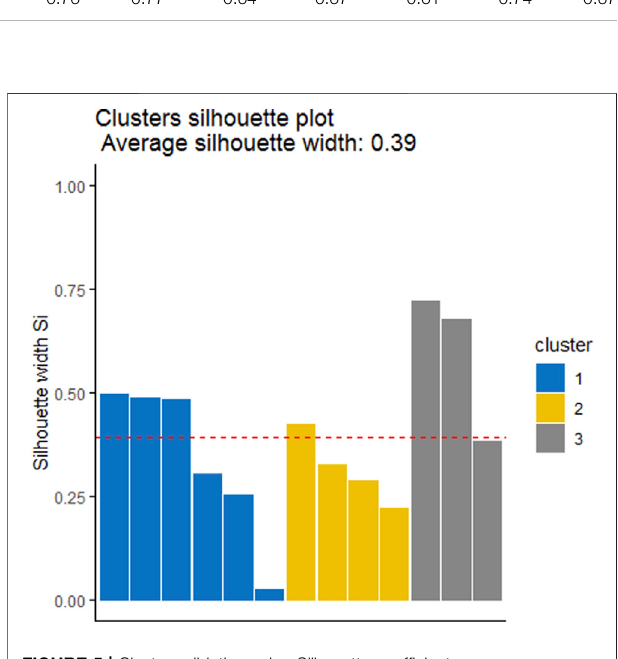
FIGURE4| Hierarchicalclusteranalysishighlighting3clusters(1,2,3)of all sites on the basis of physicochemical parameters.